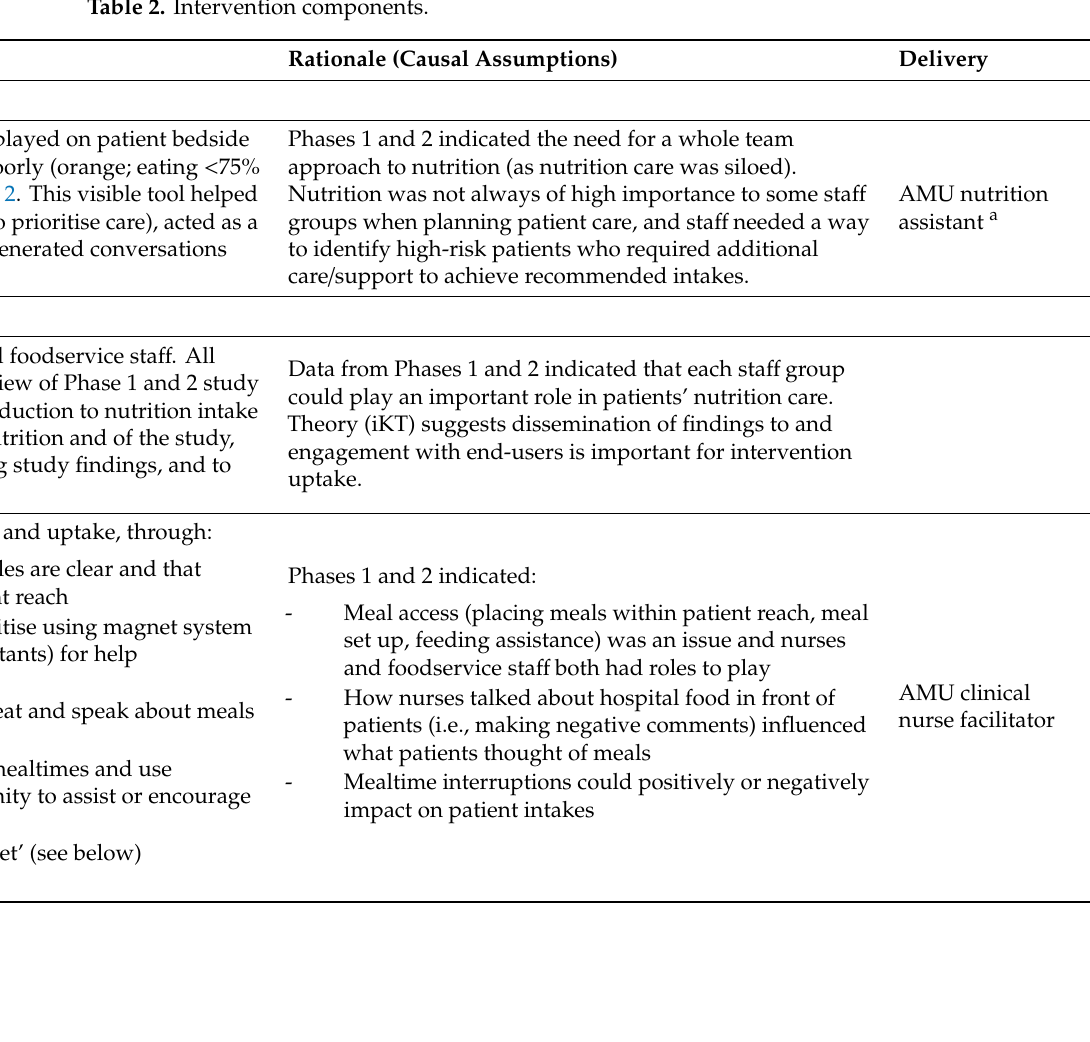
Table 2. Intervention